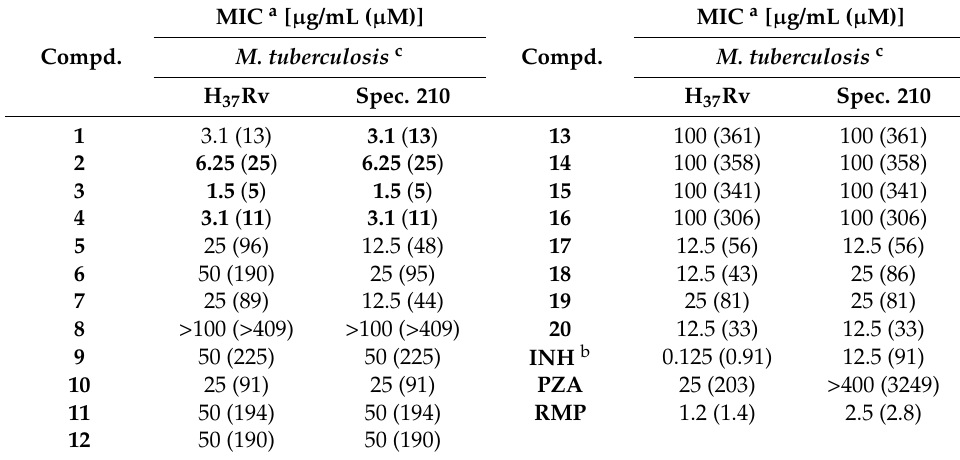
Table 1. In vitro tuberculostatic activity of compounds 1 – 20